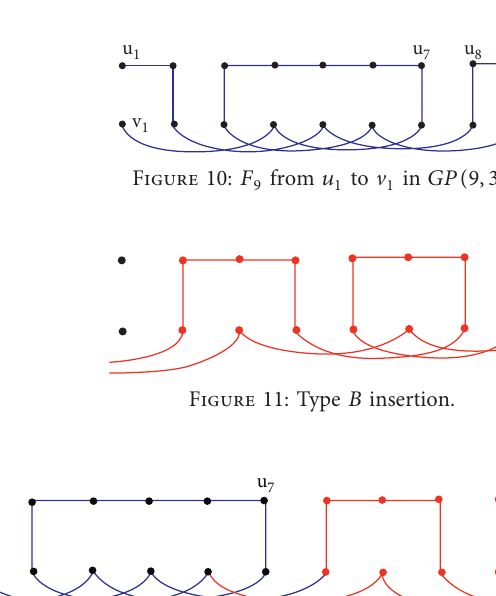
by type B insertion in GP ( 9 , 3 ) . 9